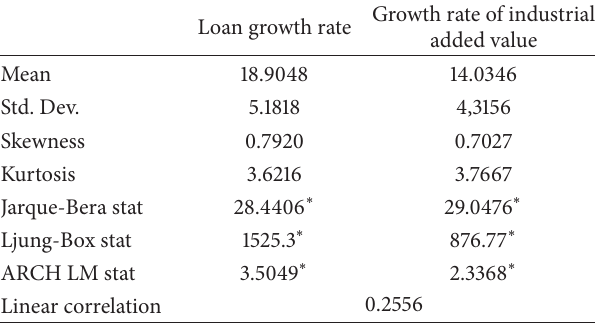
Table 1: Summary